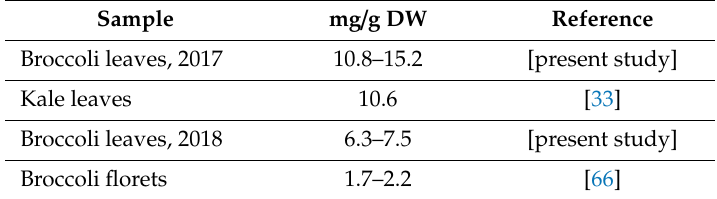
Table 7. Comparing content of phenolic compounds by methanol